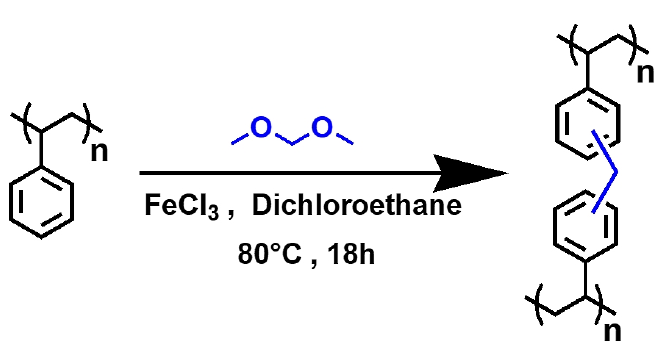
Figure 1. Formation of hyper-crosslinked polymeric material from polystyrene with the Friedel-Crafts reaction using formaldehyde dimethyl acetal (FDA) as a